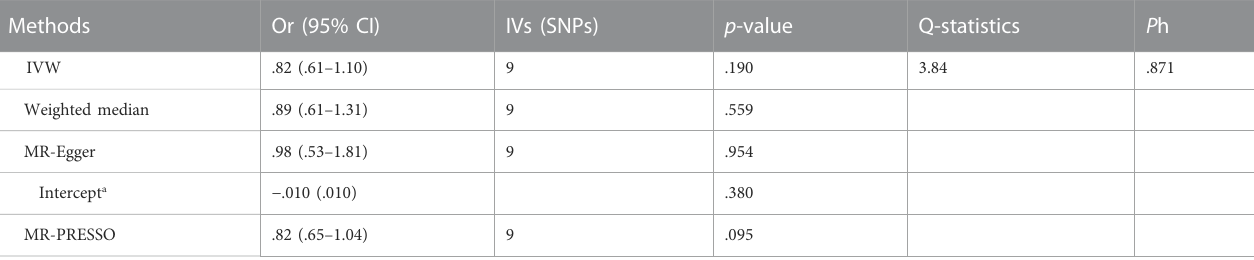
TABLE 3 Association between genetically determined bilirubin and heart failure in East Asian